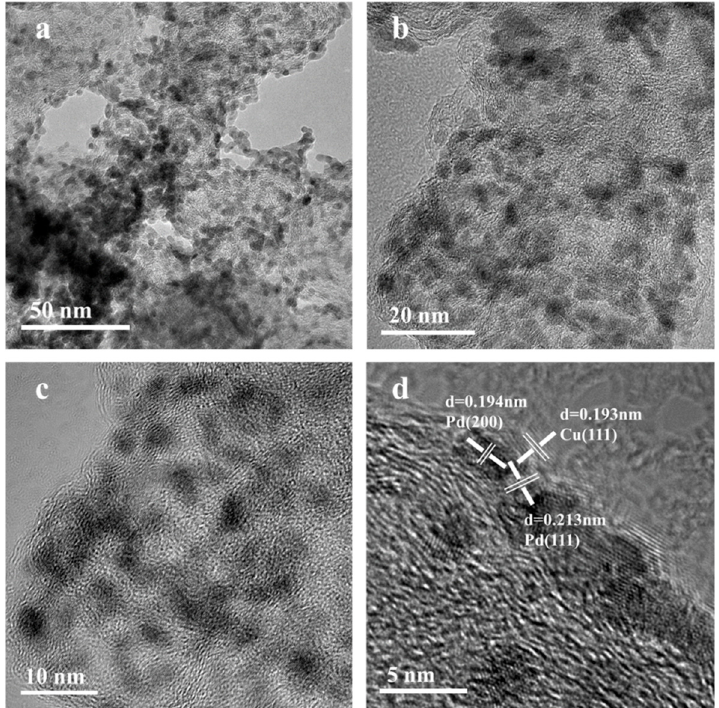
Figure 3. HRTEM image of Pd 3 Cu 2 /XC-72 ( a ) 50 nm, ( b ) 20 nm, ( c ) 10 nm, ( d ) 5 nm.